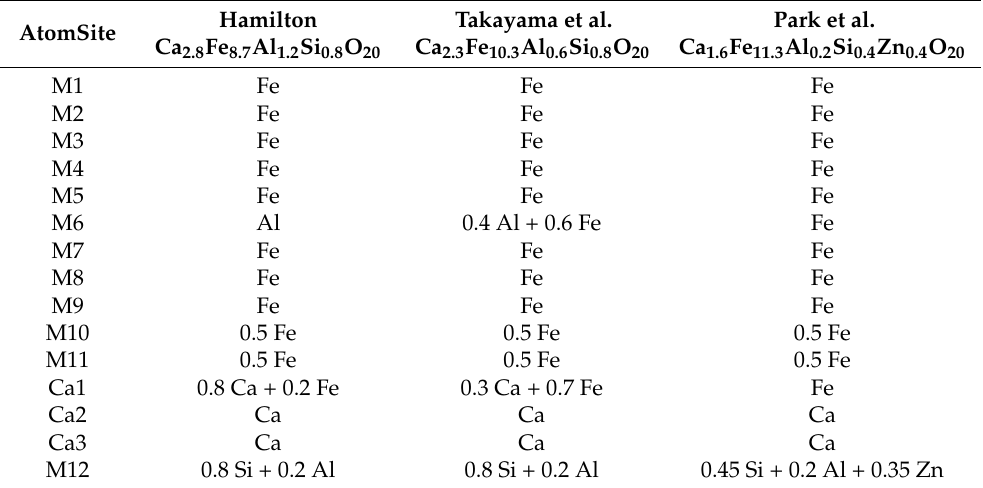
Table 7. Atomic coordinates and occupancy values for SFCA reported by Hamilton, Takayama et al. and Park et al. [17,50,56].